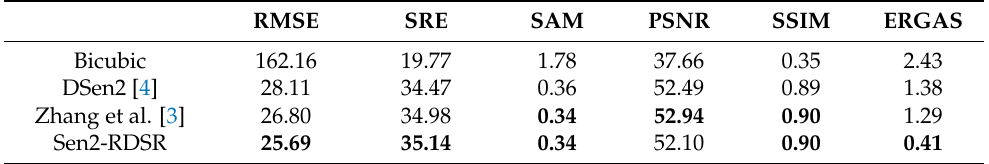
Table 3. Results of the sharpening of 60 m